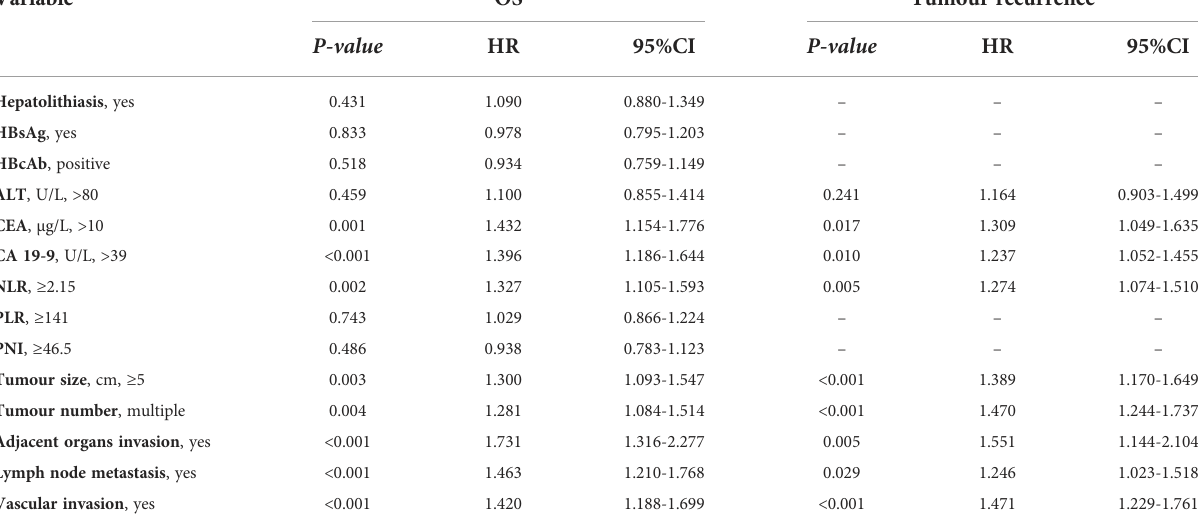
TABLE 2 Multivariate analysis of prognostic factors in ICC